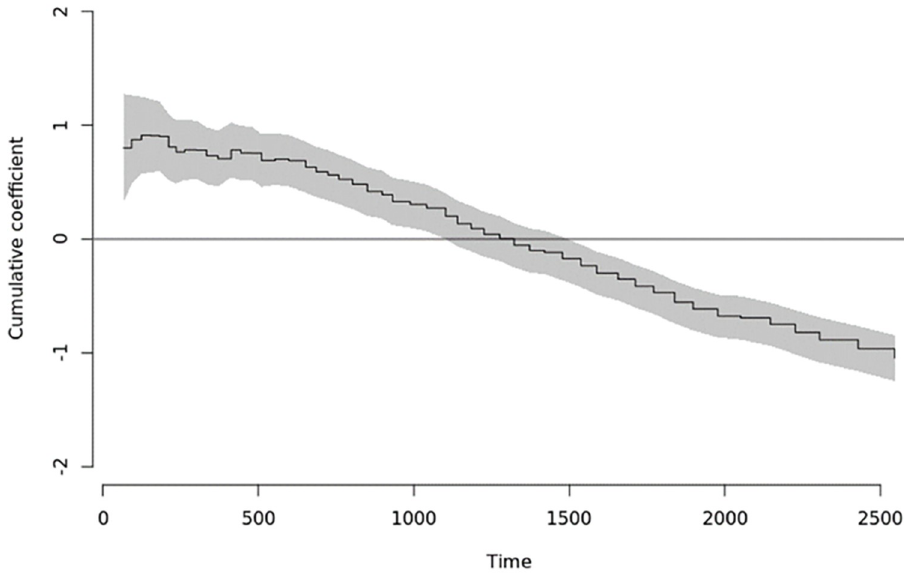
Fig 3. Time-Varying effect of anti-coagulation regimen on sub-distribution hazards for stroke.